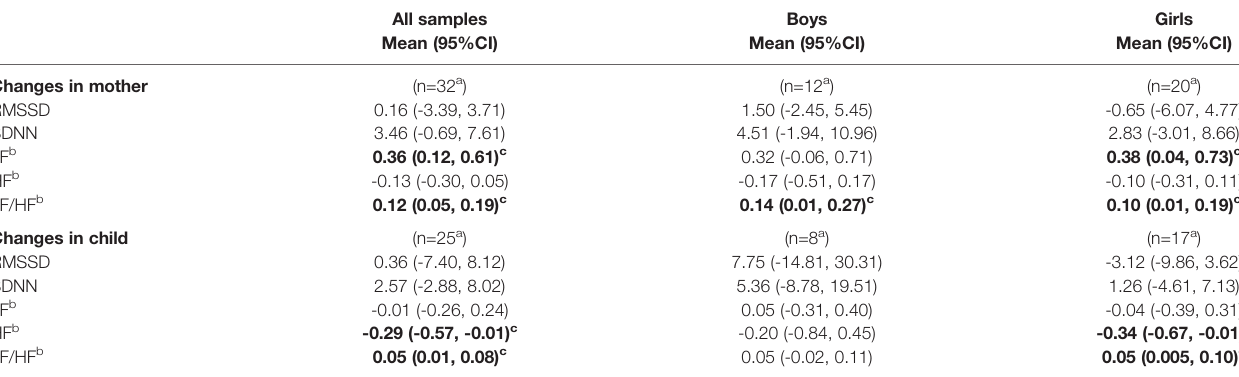
TABLE 3 | Changes in heart rate variability measures among mothers and